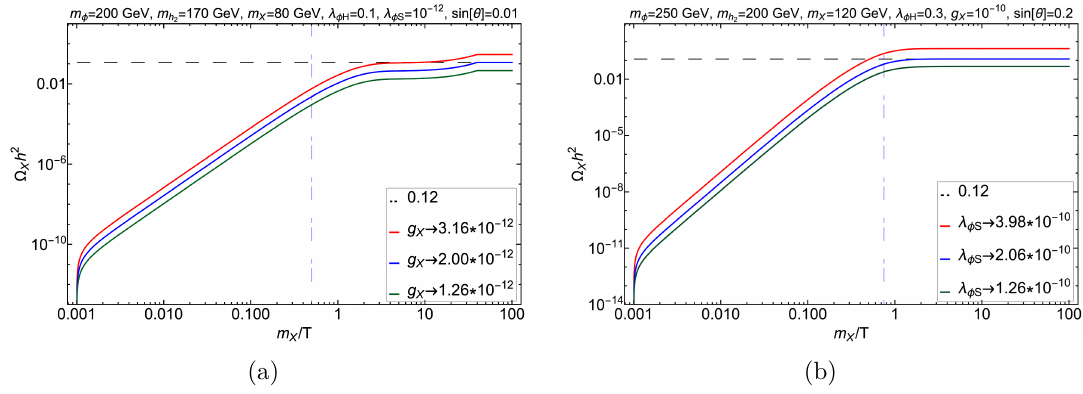
Figure 18 . Variation of X relic density as a function of x = m X /T to demonstrate freeze- in aEWSB; in left panel (figure 19(a)) we show decay dominant case where freeze-in production aEWSB occurs via h 2 → XX for three discrete g X values. In the right panel figure 19(b), decay is kinematically forbidden and scattering processes dominate freeze-in production. Vertical dot- dashed line indicates EWSB and black dashed line shows the central value of observed relic